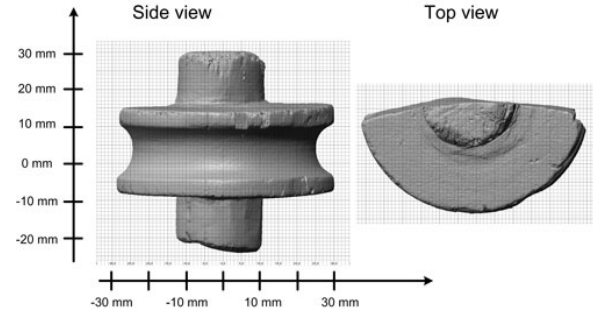
Figure 9. 3D model of a broken wooden pulley.